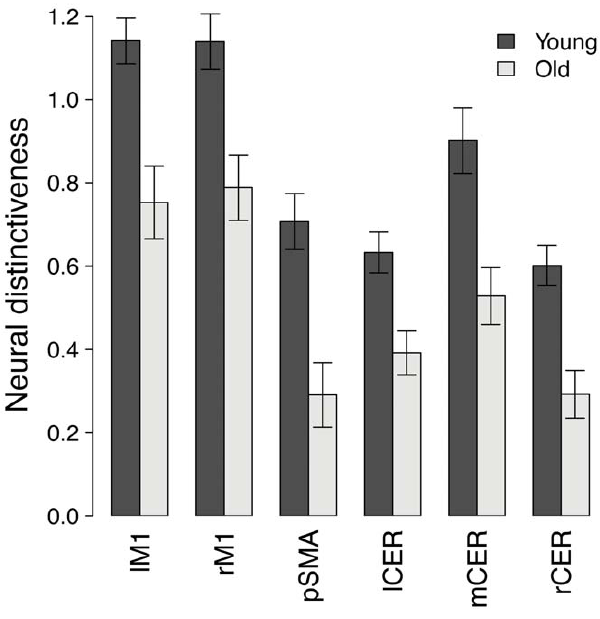
Figure 2. Region-of-interest analysis of neural distinctiveness in the motor network. Neural distinctiveness was reduced through- out the motor network in older adults, relative to young adults. Error bars denote the standard error of the mean.